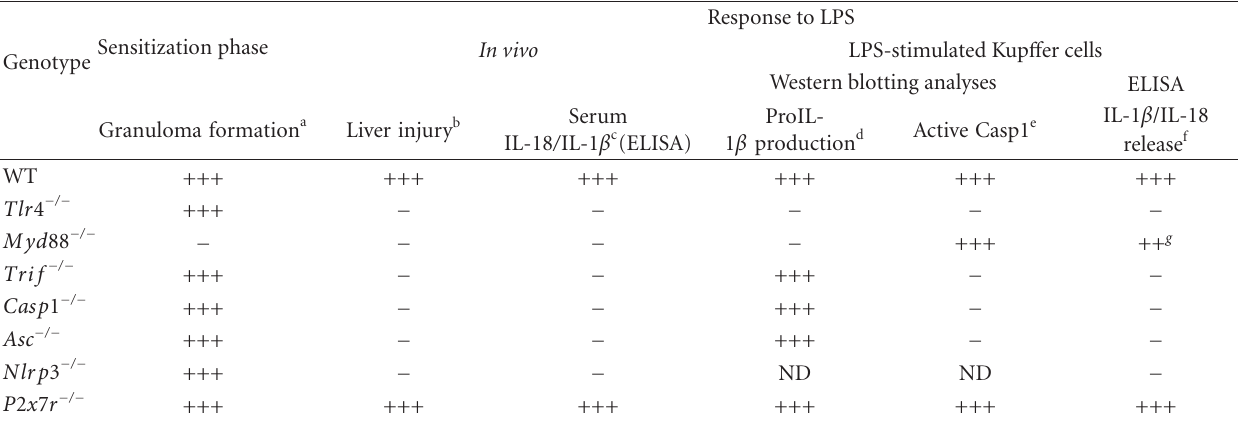
Table 3: Requirement of MyD88 and TRIF for LPS sensitization and Caspase-1 activation, respectively. Mice with various genotypes were sequentially treated with P. acnes and LPS, and liver specimens and sera were sampled for histological analyses and measurement of IL- 18/IL-1 β levels by ELISA, respectively. Kup ff er cells were incubated with LPS for 4 h, and each supernatant was collected for western blotting analyses and ELISA. Na¨ıve mice have no hepatic granulomas or injuries, and their serum IL-18 and iL-1 β were undetectable. Na¨ıve Kup ff er cells released no IL-18 and IL-1 β